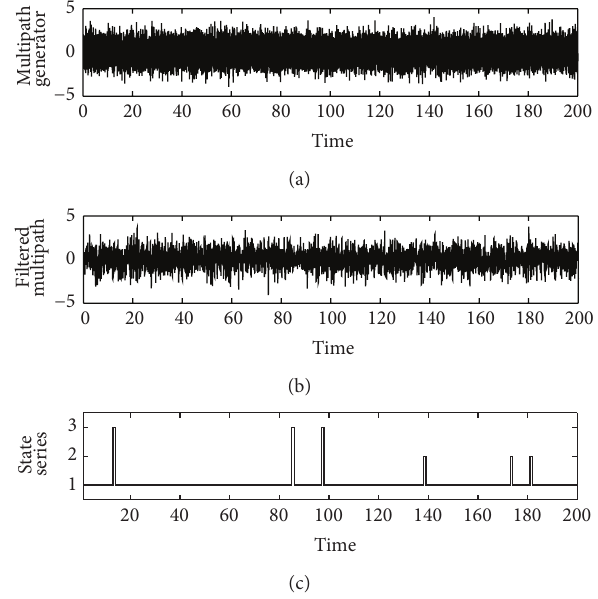
Figure 6: Zoomed in versionof thegenerated signal and stateseries: (a) generated samples, (b) filtered signal, and (c) state series.